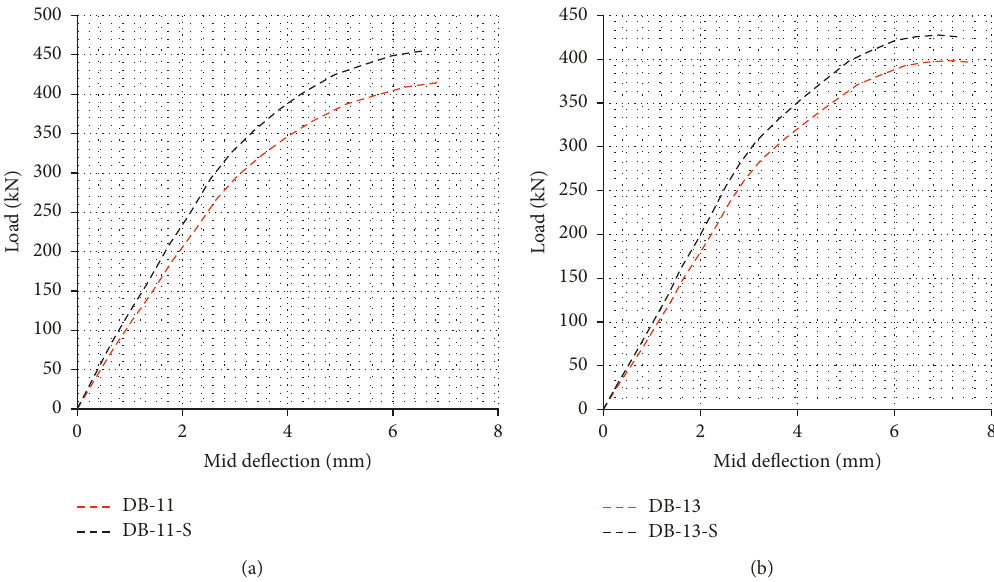
Figure 11: Load-deflection response curves with different spacing of stirrups (100mm and 50mm). (a) Beam with L/D and L/R ratios equal to 3 and 1.05, respectively, and (b) beam with L/D and L/R ratios equal to 3 and 1.57,